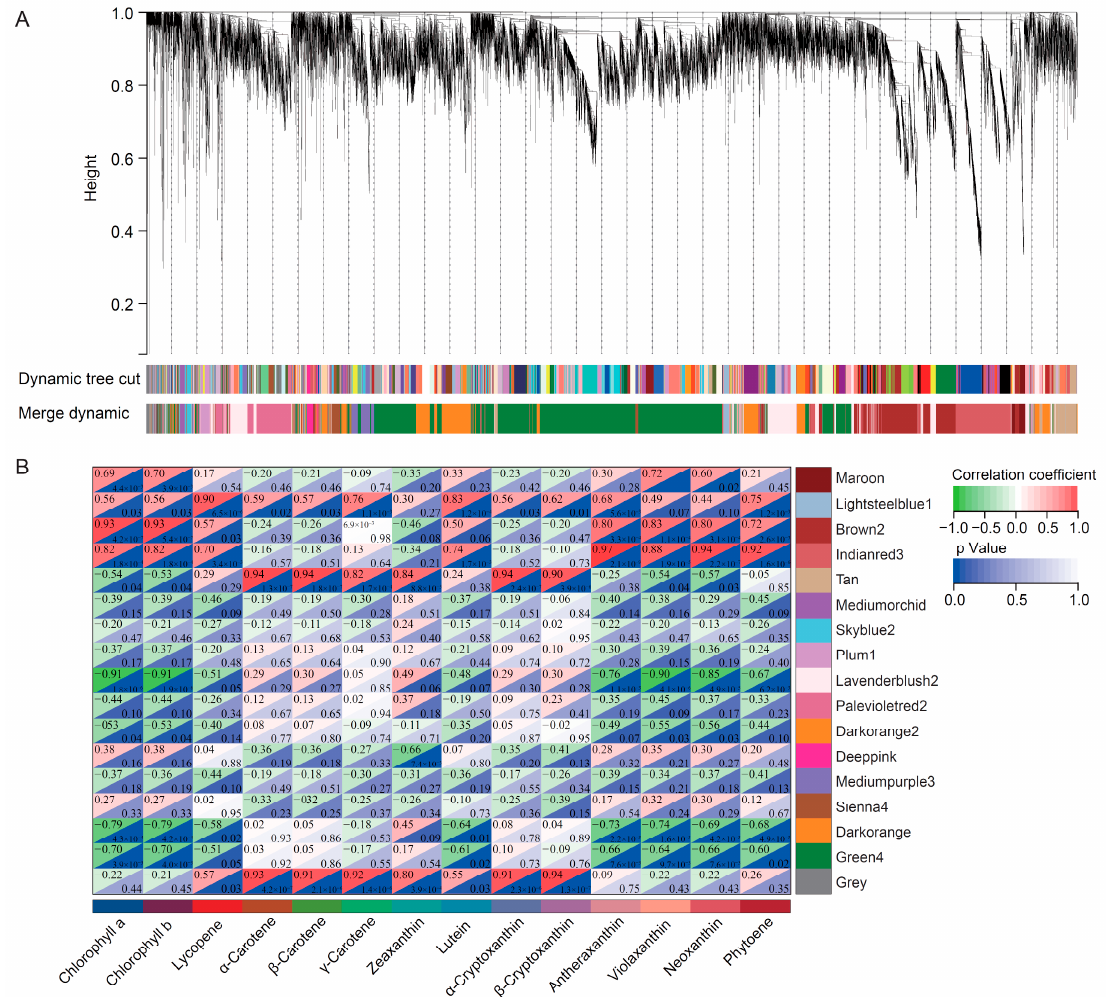
Figure 4. A weighted gene co-expression network analysis of DEGs in ripe fruits of five sea buckthorn varieties: ( A ) cluster dendrogram showing the gene co-expression modules from the WGCNA analysis; ( B ) module–chlorophyll and module–carotenoid relationships. Each row represents a module. Each column represents a specific chlorophyll or carotenoid. The value in each cell represents the correlation coefficient between the module and the chlorophyll or carotenoid, as well as the p